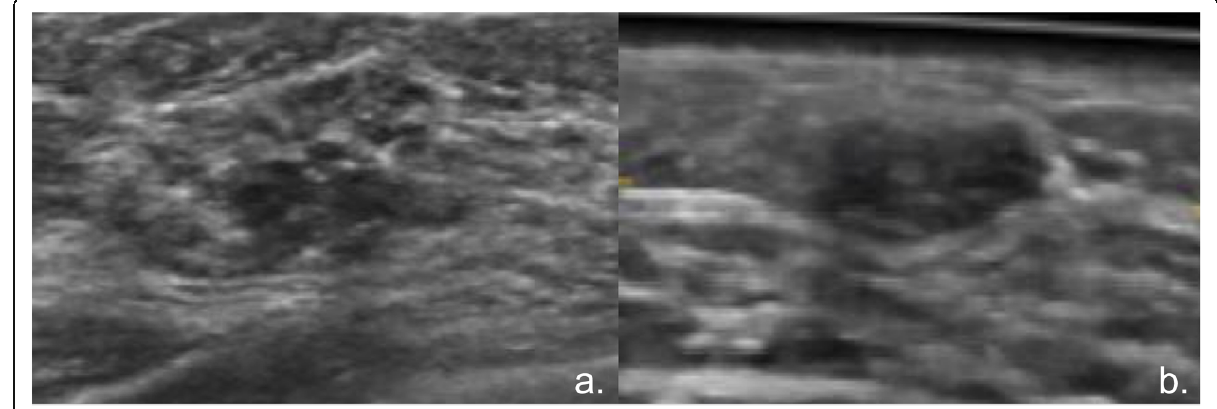
Fig. 5 Lesions falsely classified as normal tissue using machine learning with the reduced feature set but correctly classified with the full feature set: invasive ductal carcinoma (maximal diameter 10 mm) in a 74-year-old patient ( a ) and fibroadenoma (maximal diameter 9 mm) in a 46-year- old patient ( b ). Lesion ( a ) was also falsely classified as benign in the comparison between malignant and benign lesions